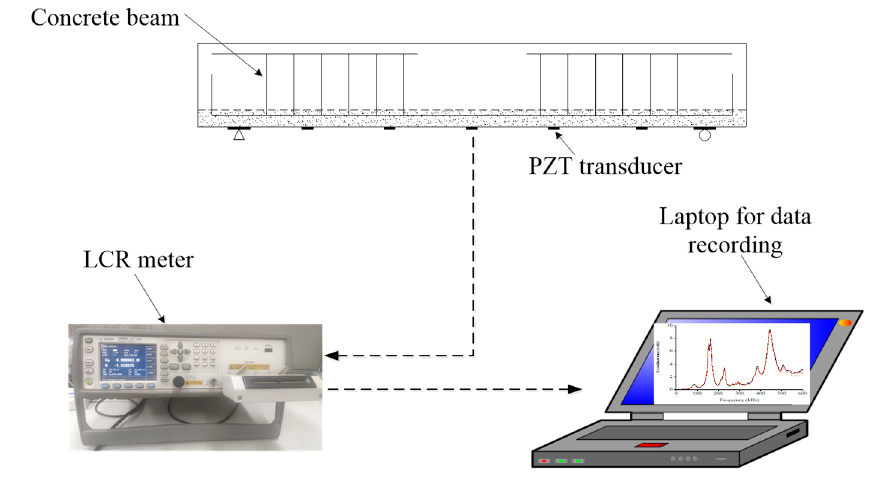
Figure 5. Schematic diagram of the experimental setup for electrical conductance acquisition.